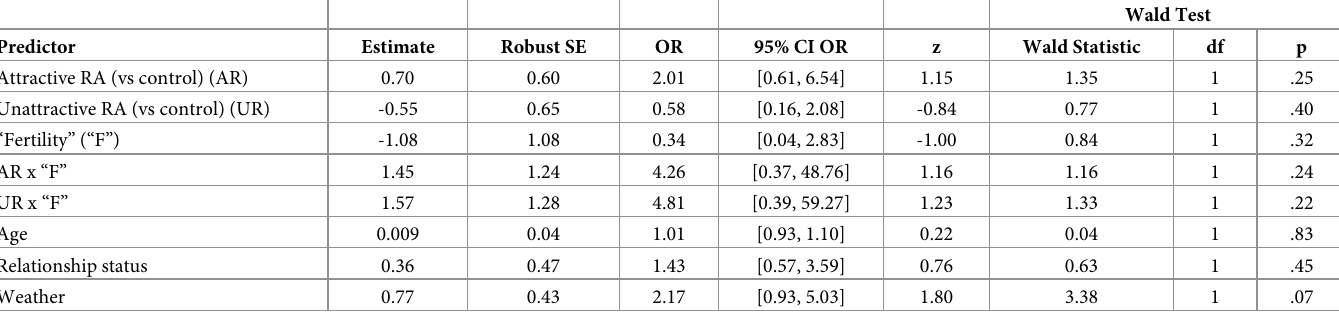
Table 4. Regressing the likelihood of wearing red (0: no vs 1: yes) from the attractiveness of the research assistant, fertility, attractiveness x fertility interaction, con- trolling for age, relationship status and weather for hormonal contraceptive users.